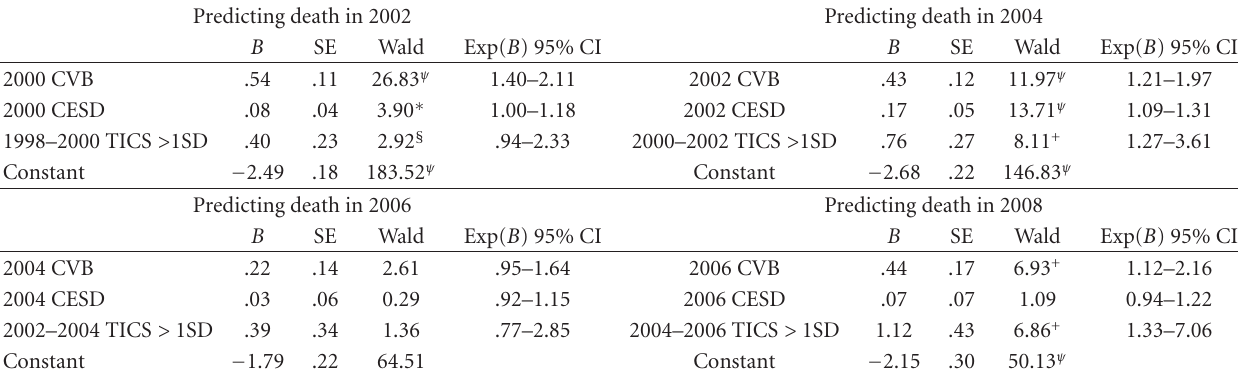
Table 3: Results of logistic regression analyses predicting death at 2002, 2004, 2006, and 2008 waves based on depressive symptoms and incidence of cognitive